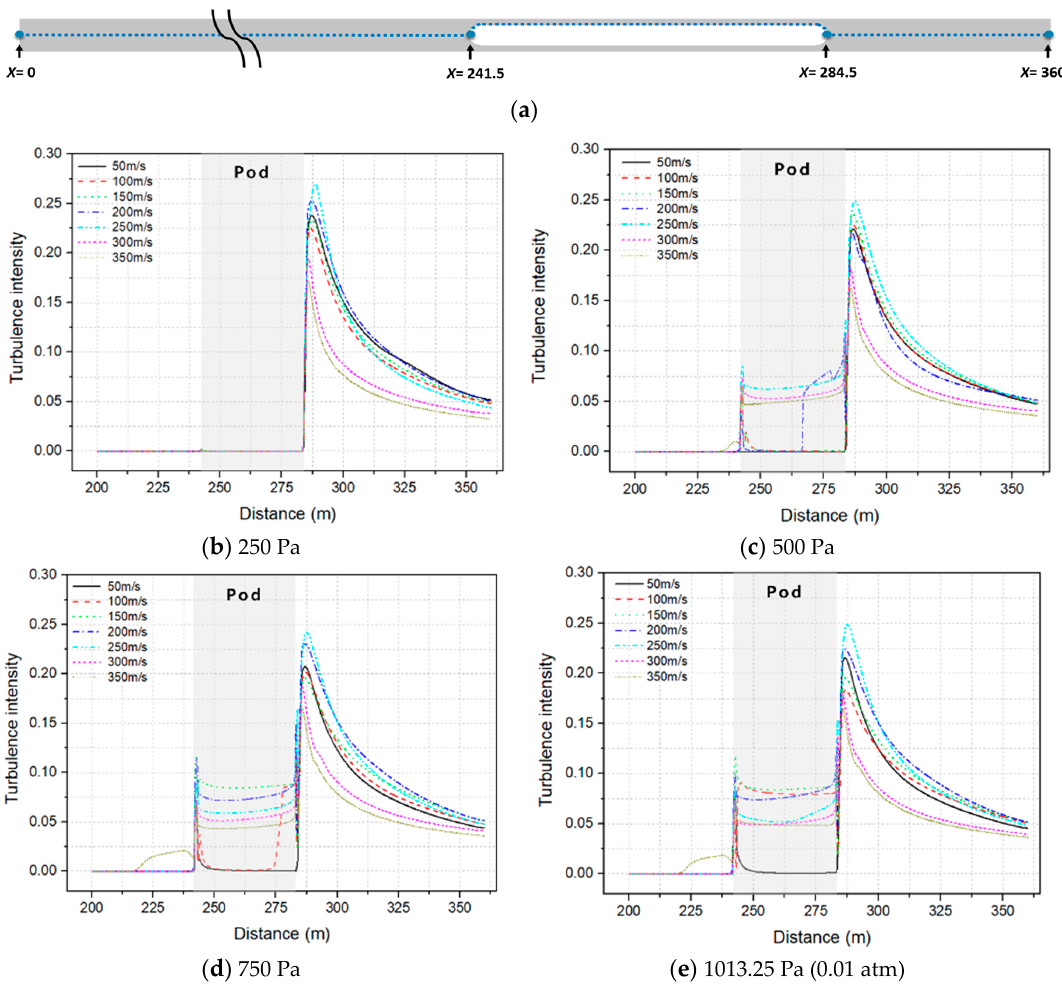
Figure 10. ( a ) Center line and line along the pod surface. ( b )–( e ) Turbulence intensity variation for various tube pressures.